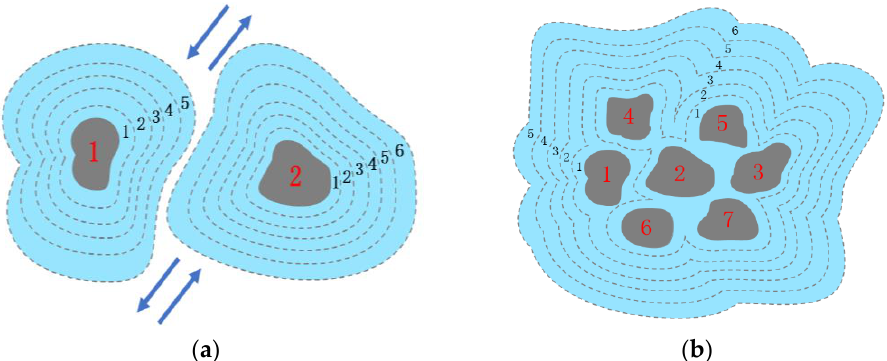
Figure 11. ( a ) Flocculation network structure in cemented slurry; ( b ) suspension mechanism of small solid particles in cemented slurry.